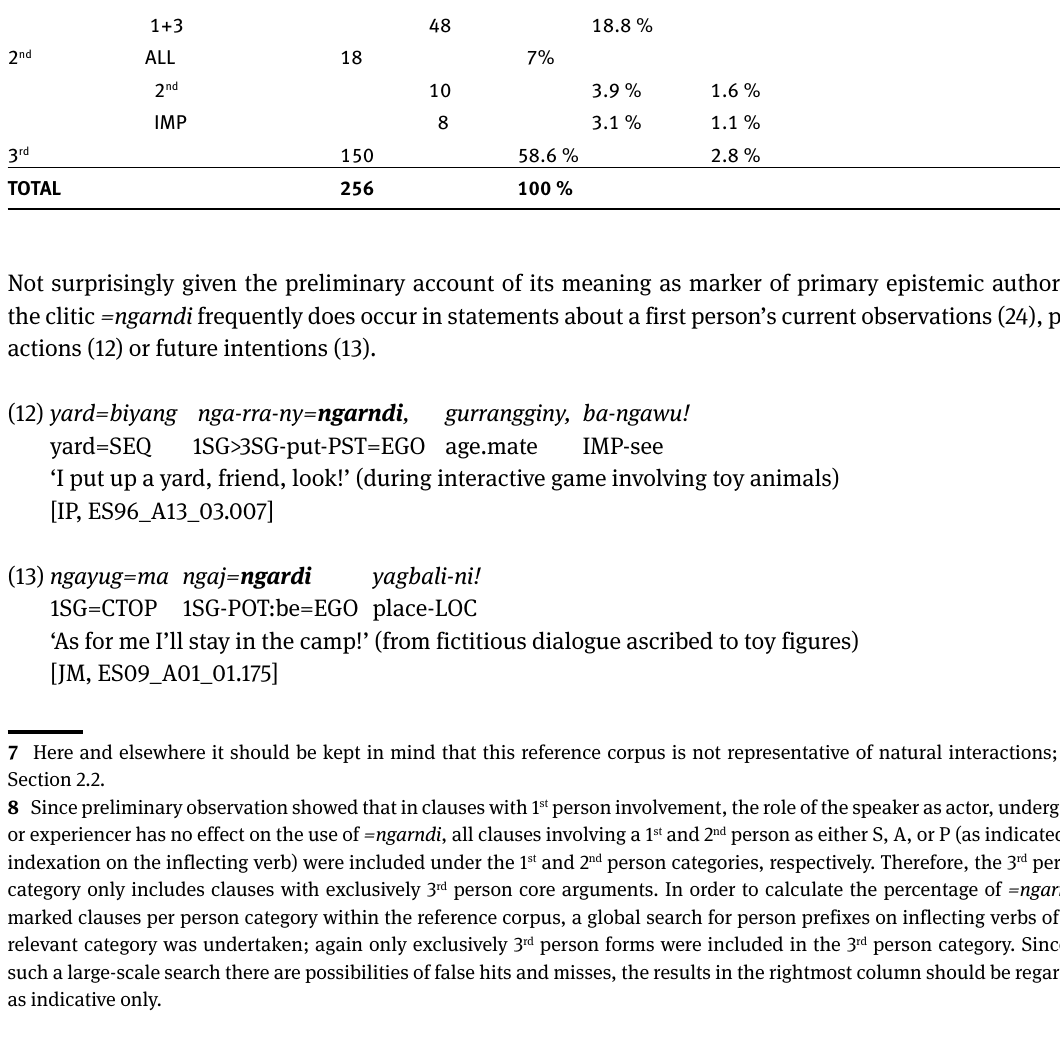
Table 1 : Frequency of =ngarndi ‘EGO’ with different person categories (whenever encoded as S, A, or P)8 Person Nr of tokens Proportion of tokens Approximate proportion of clauses with this of =ngarndi person category ALL 88 34.4 % 3.8 % 40 15.6 %